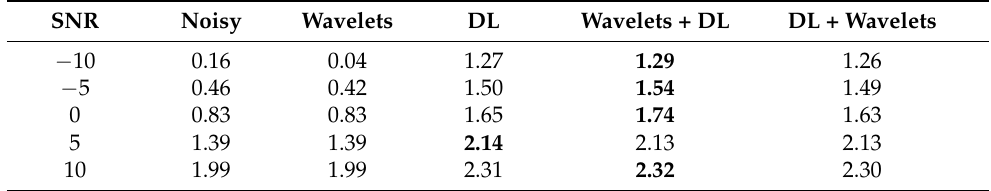
Table 3. Pink noise PESQ. The higher values represent better results. In bold is the best result for each SNR level.